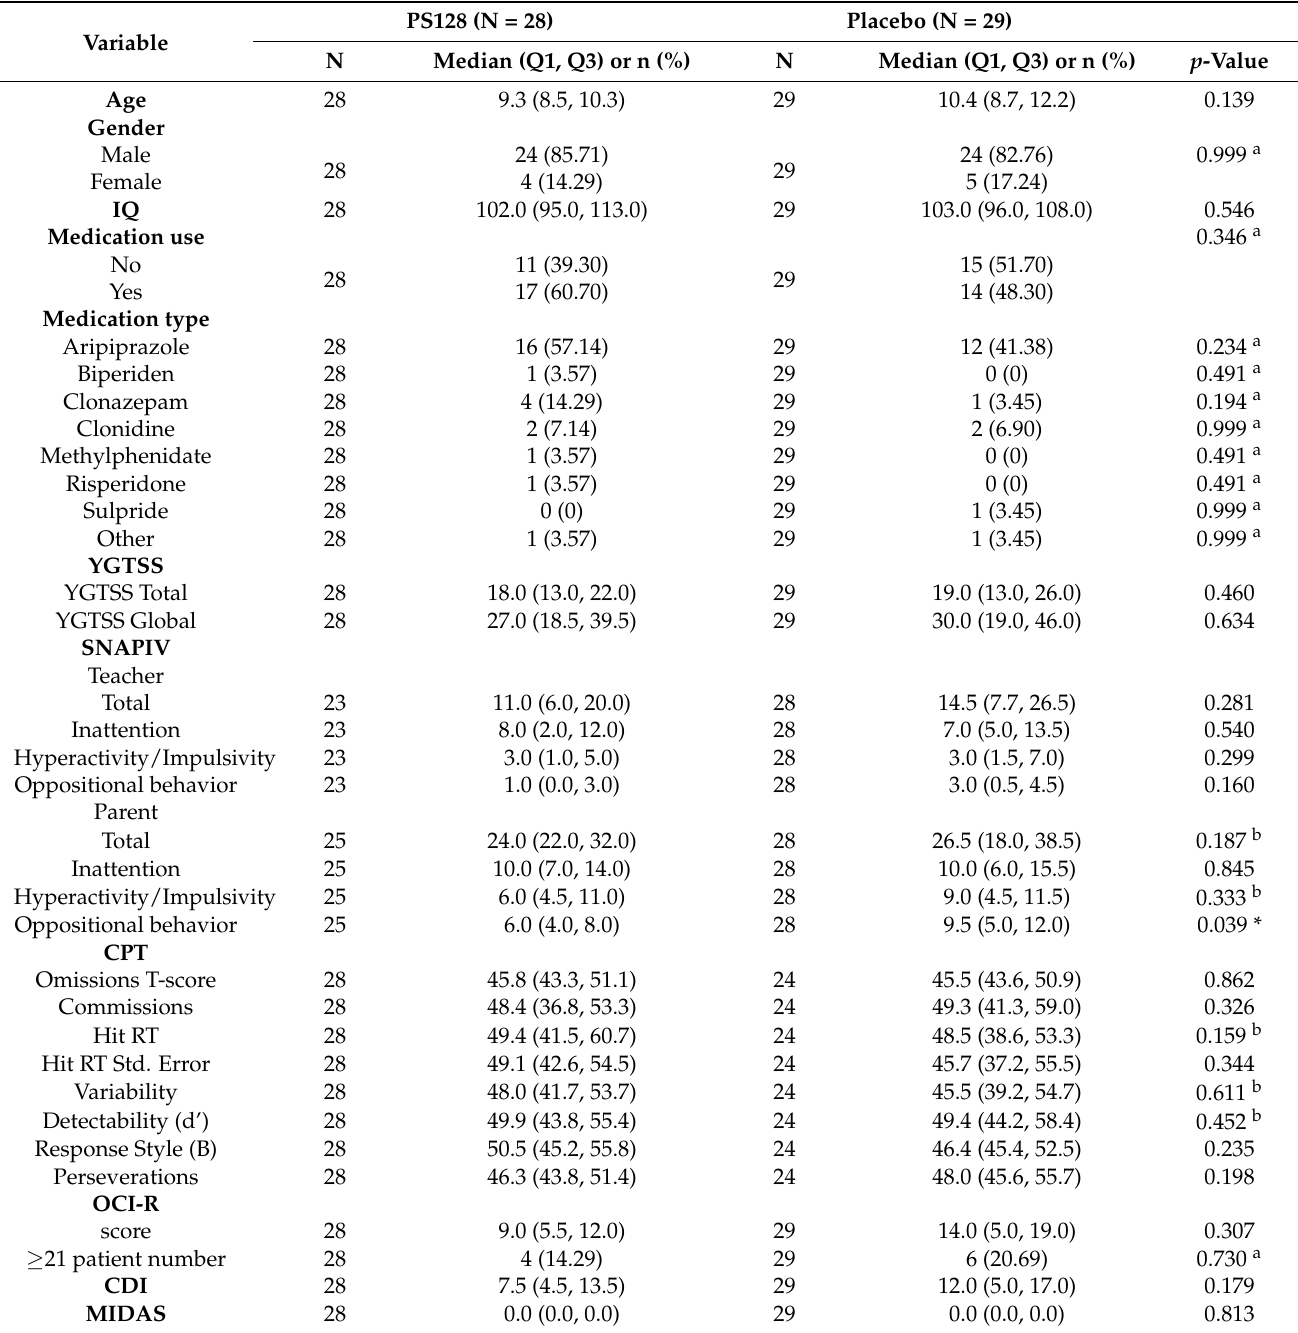
Table 1. Patient characteristics, baseline YGTSS, and comorbidity